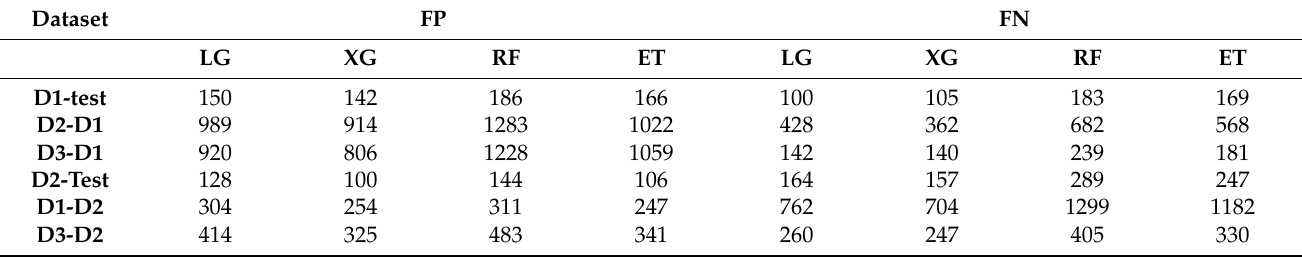
Table 10. Comparison of False Positives and False Negatives for LightGBM, XGBoost, Random Forest and